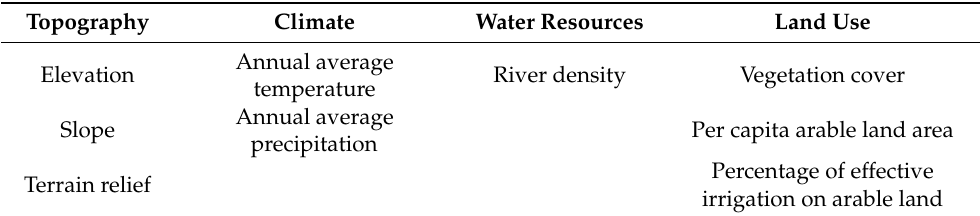
Table 1. Description of geo-environmental